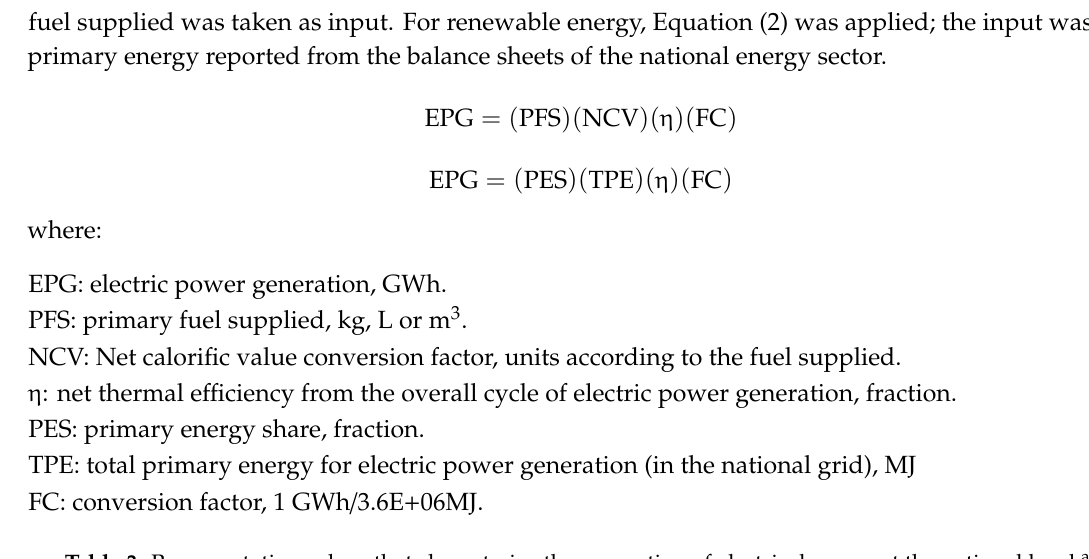
Table 3. Representative values that characterize the generation of electrical power at the national level a